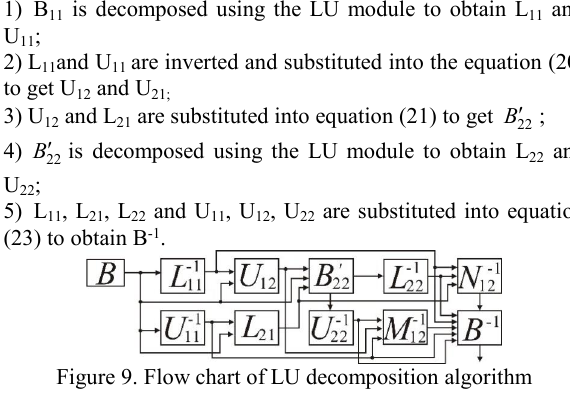
Figure 9. Flow chart of LU decomposition algorithm